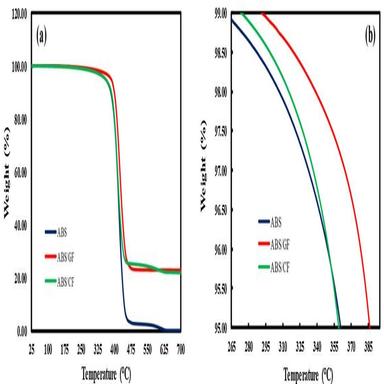
Representative single specimen TGA of ABS and ABS based composite (a) weight loss thermogram and (b) 1 to 5 % weight loss in thermogram.